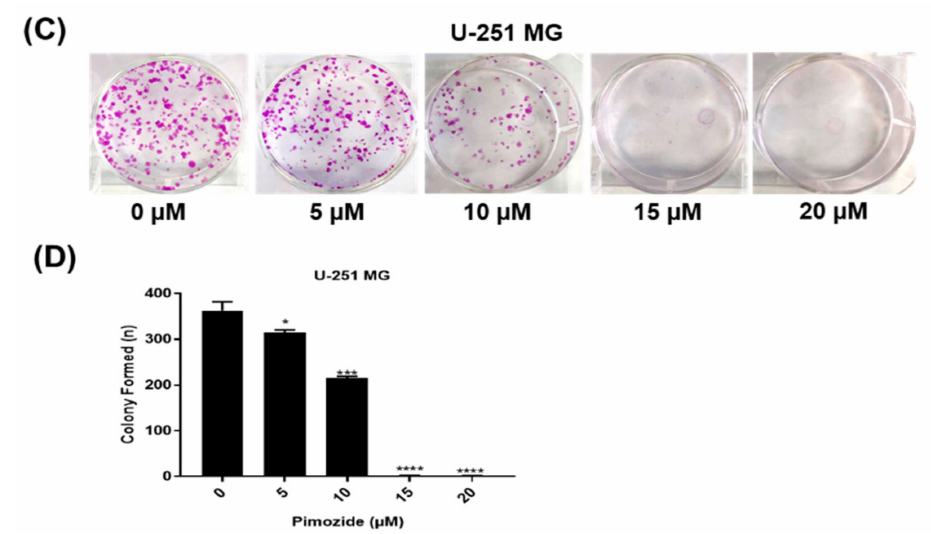
Figure 3. Pimozide inhibits the colony-forming ability of brain tumor cells. ( A ) Daoy cells were treated with sub-toxic and toxic concentrations of pimozide (5 µ M, 10 µ M, 15 µ M, and 20 µ M) for 48 h. The colony-inhibiting e ff ects of pimozide were assessed by clonogenic assay. ( B ) Quantitative representation of the colonies formed in Daoy cells. The experiments contained two replicates in each experiment. Values are plotted as mean ± SD, and the statistical significance level was considered as p < 0.05 **** p ≤ 0.001) ( C ) U-251 MG cells were treated with sub-toxic and toxic concentrations of pimozide (5 µ M, 10 µ M, 15 µ M, and 20 µ M) for 48 h. The colony-inhibiting e ff ects of pimozide were assessed by clonogenic assay. ( D ) Quantitative representation of the colonies formed in U-251 MG cells. The experiments contained two replicates in each experiment. Values are plotted as mean ± SD, and the statistical significance level was considered as p < 0.05 (* p ≤ 0.5, *** p ≤ 0.01, **** p ≤ 0.001).